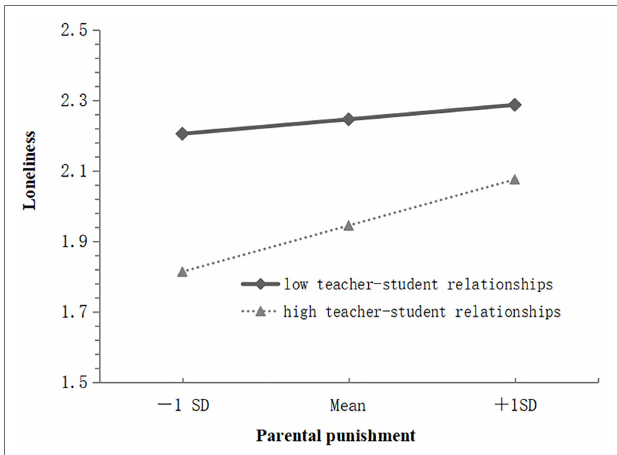
FIGURE 3 | Plot of the interaction between parental punishment and teacher-student relationships on